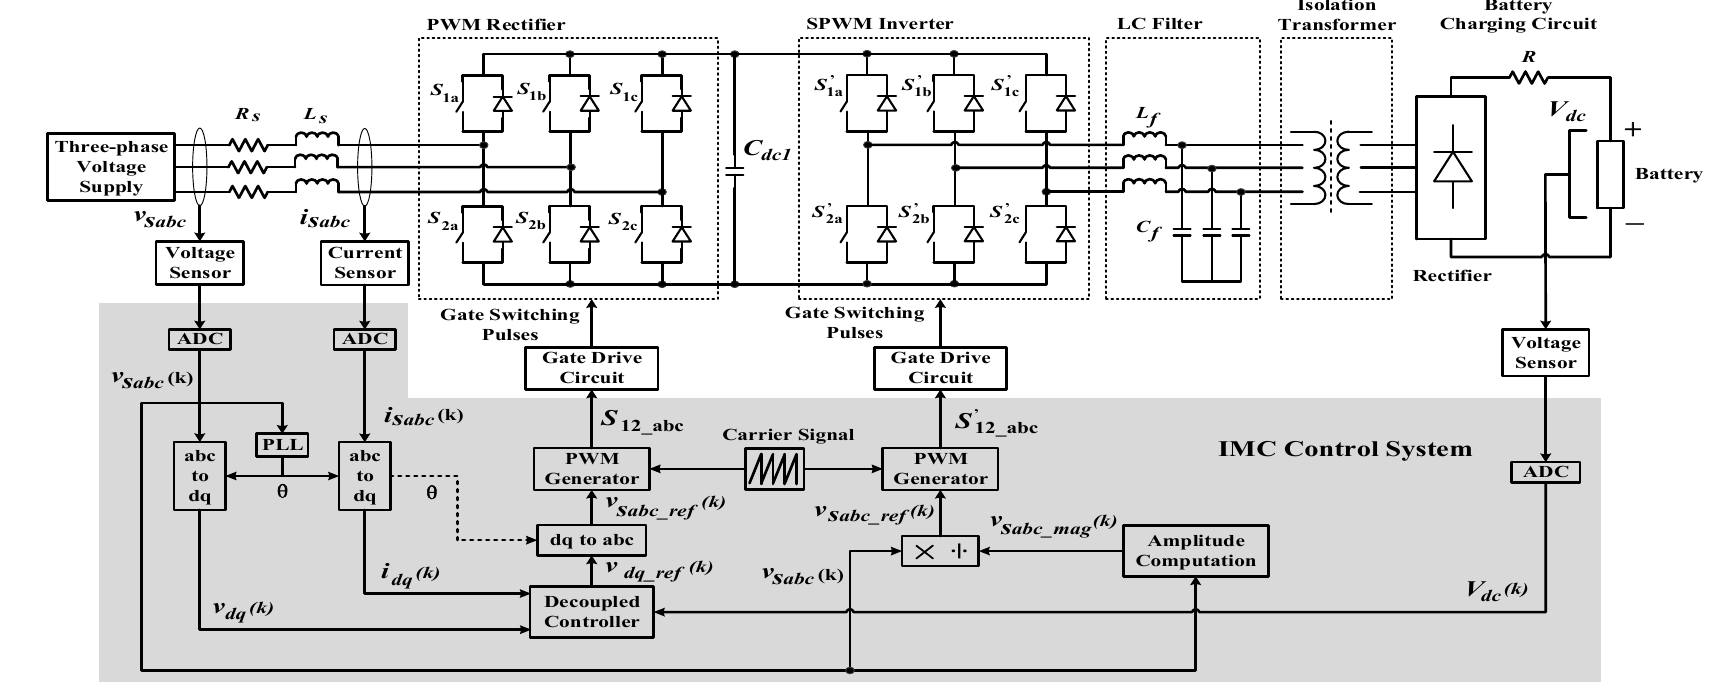
Figure 3. IMC with synchronize decoupled controllers integrated to three stage of the proposed EV charger .